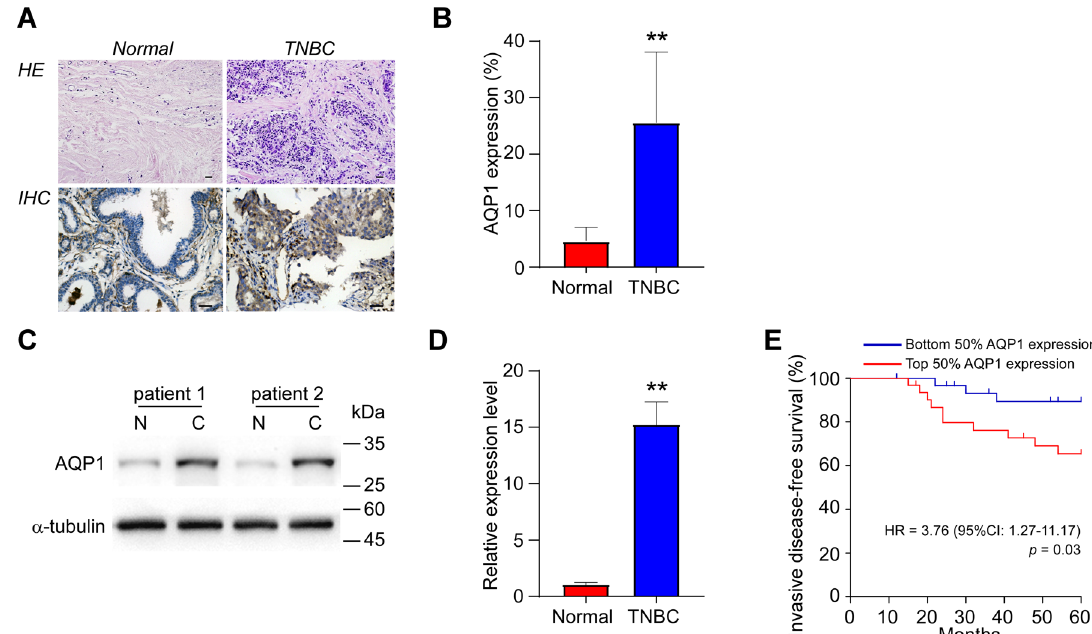
Fig. 1 AQP1 is upregulated in TNBC and associated with poor survival. A Representative images of hematoxylin – eosin ( above , HE, ×100 magni fi cation) and anti-AQP1 immunohistochemistry ( below , IHC, ×200 magni fi cation) staining of TNBC and normal breast tissue. Scale bar : 40 μ m. B Quanti fi cation of the AQP1-positive cell percentage in TNBC and normal breast tissue ( n = 62). C Representative blotting of Western blot analysis of TNBC and normal breast tissue. Abbreviations : N, normal breast tissue; C, TNBC. D Quanti fi cation of relative expression levels of AQP1 in TNBC and normal breast tissue ( n = 62). E Kaplan – Meier survival plot showing the invasive-disease-free survival of TNBC patients in the current cohort strati fi ed by dichotomic expression levels of AQP1 ( n = 31 for each group). Note : ** p <